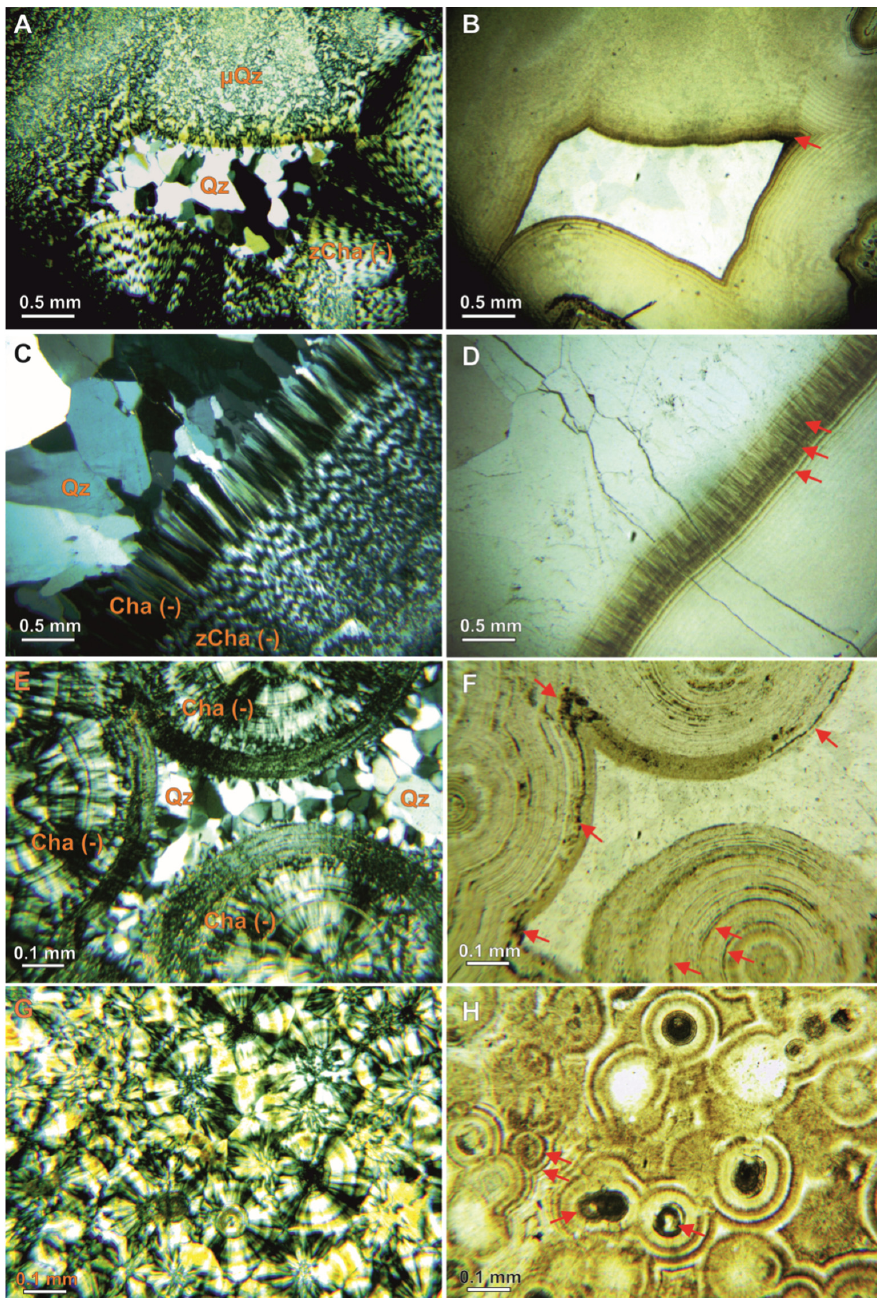
Figure 6. Microphotographs of agates with Fe-oxide pigment: ( A , B ) microgeode of macrocrystalline quartz within a matrix of microcrystalline quartz and zebraic chalcedony; ( C , D ) alternate silica phases in the internal part of the agate with microcrystalline quartz, zebraic chalcedony, length-fast chalcedony, macrocrystalline quartz and crosscutting calcite veinlet; ( E , F ) chalcedony spherulites associated with macrocrystalline quartz; ( G , H ) dense accumulation of chalcedony spherulites. ( A , C , E , G )—polarized light, crossed nicols; ( B , D , F , H )—plane polarized light. The micrographs ( B , D , F , H ) show that the macroscopically visible red colour is caused by the incorporation of Fe-oxide/hydroxide minerals along the chalcedony banding (see arrows). Abbreviations: Cha (-), length-fast chalcedony; zCha (-), zebraic chalcedony; Qz, macrocrystalline quartz; µQtz, micro- crystalline quartz. The red arrows in figures indicate the location of chromogenic minerals along the strips.